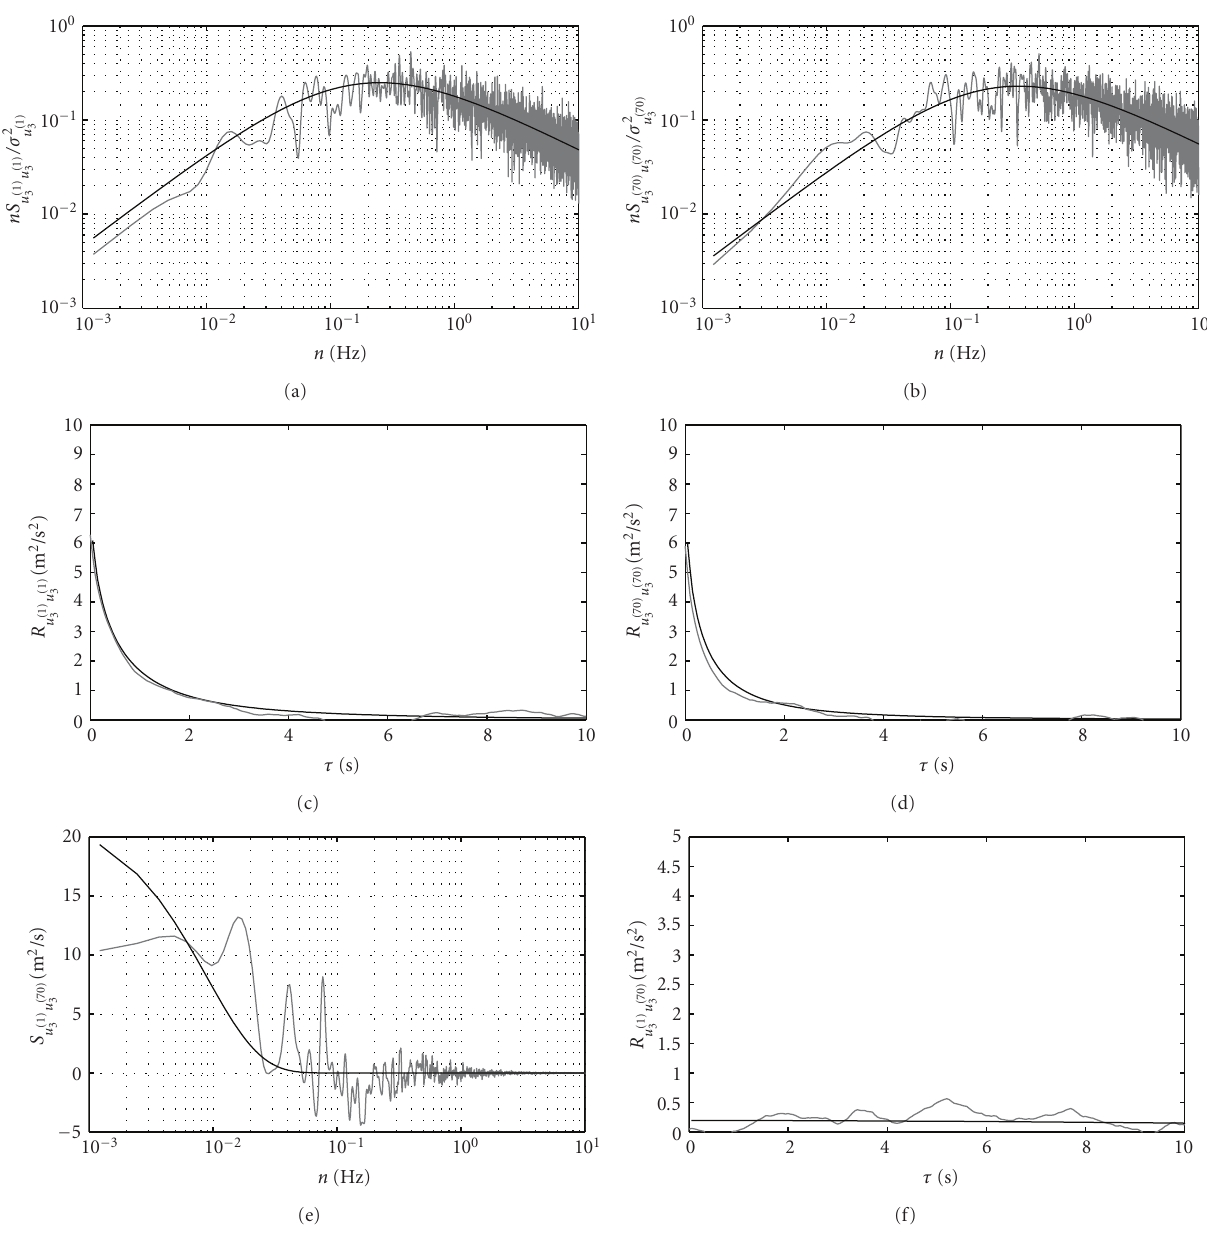
Figure 12: Example 2 using POD method (black lines denote target functions, gray lines denote numeric approximations): auto-spectra of across-wind velocities at points 1 and 70 (a), (b); corresponding autocorrelation functions (c), (d); cross-spectrum between along-wind velocities at points 1 and 70 (e); corresponding cross-correlation function